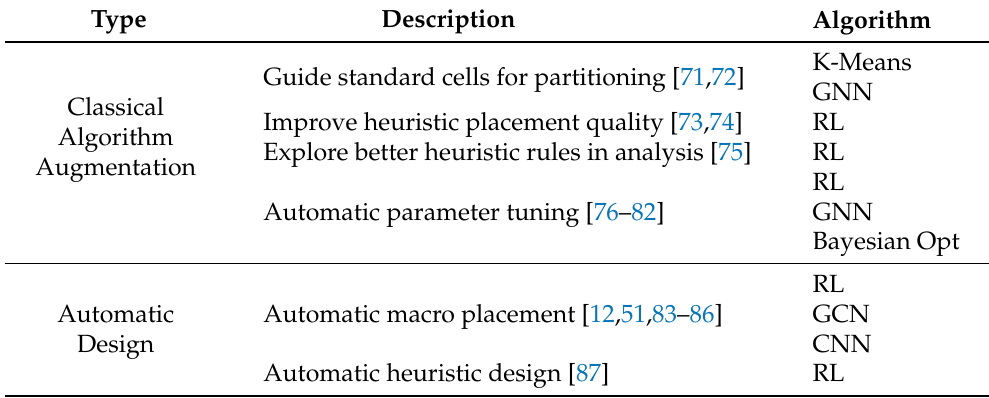
Table 3. Recent studies on learning-based placement optimization